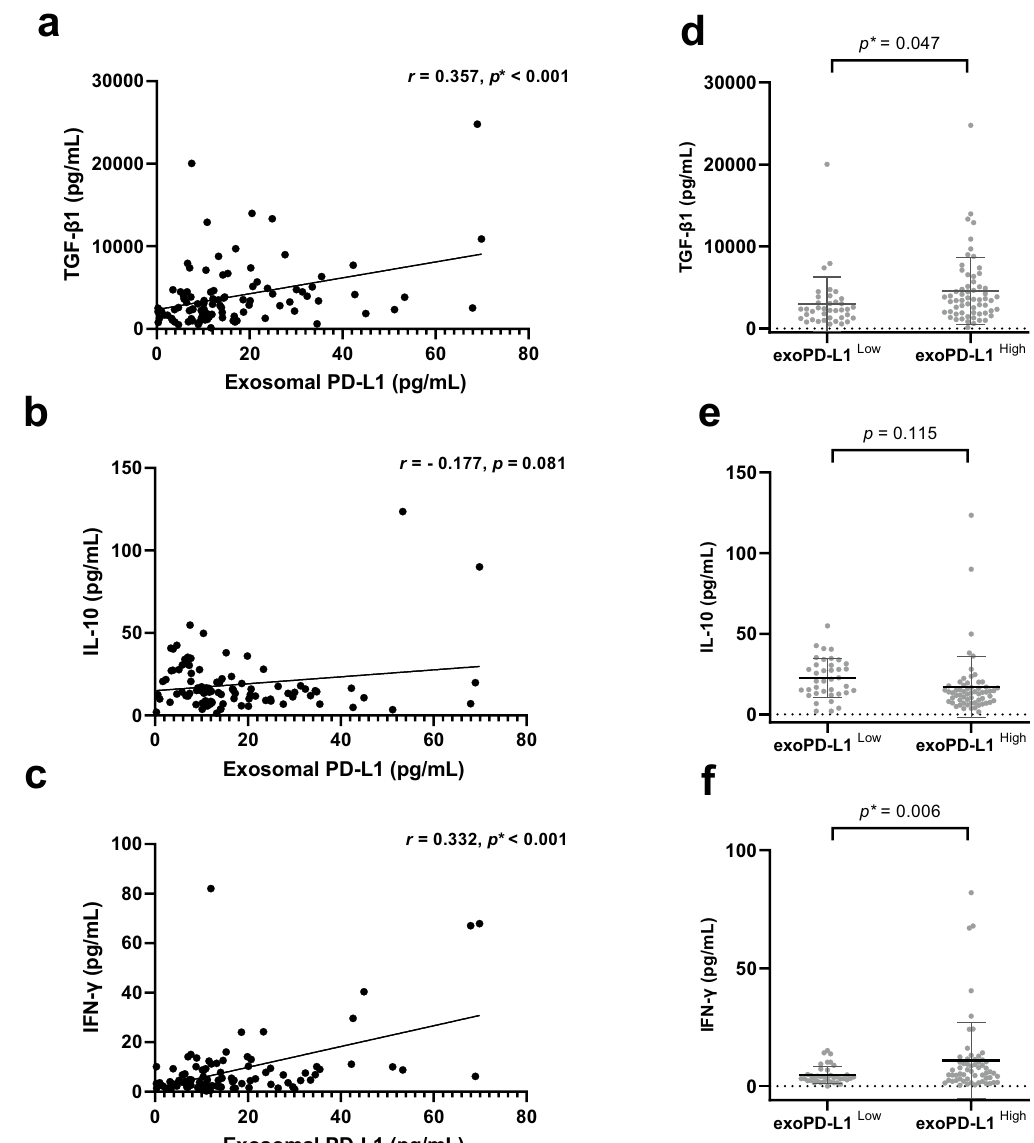
Figure 4. Correlation between baseline exoPD-L1 and cytokines. ( a , c ) exoPD-L1 showed a positive correlation with TGF-β1 and IFN- γ . ( b ) exoPD-L1 tended to negatively correlate with IL-10. ( d , f ) a higher level of TGF-β1 and IFN- γ was found in the high exoPD-L1 group than in the low exoPD-L1 group. ( e ) IL-10 level was higher in low exoPD-L1 group without significance. Spearman’s correlation analysis was performed in ( a – c ) Unpaired t -test was performed between two groups ( d – f